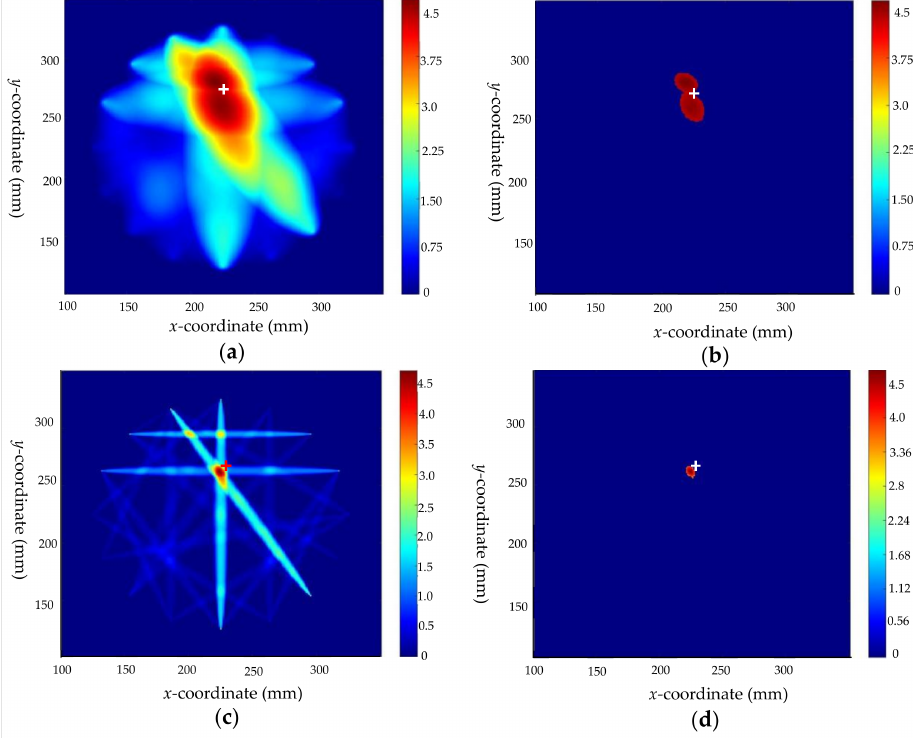
Figure 12. Comparison of imaging results before and after optimization of defect 3: ( a ) imaging results before optimization; ( b ) the threshold processing result before optimization; ( c ) image result after optimization; and ( d ) the threshold processing result after